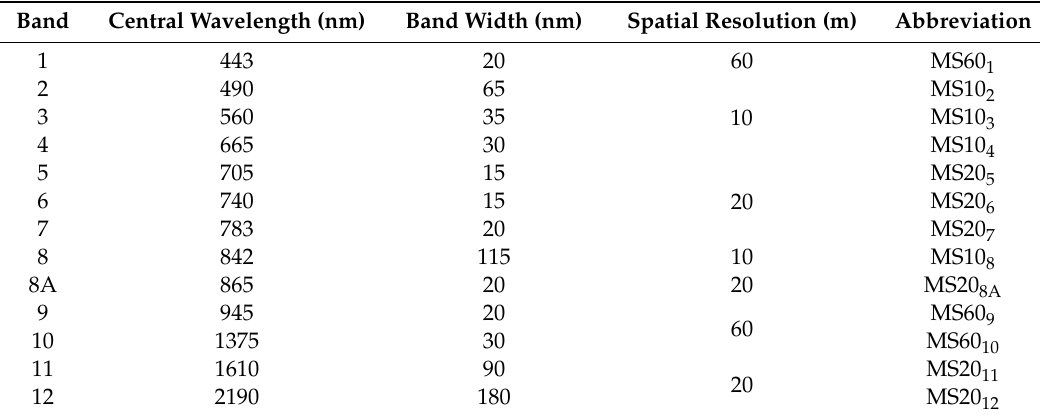
Table 1. Some specifications of Sentinel-2 imagery